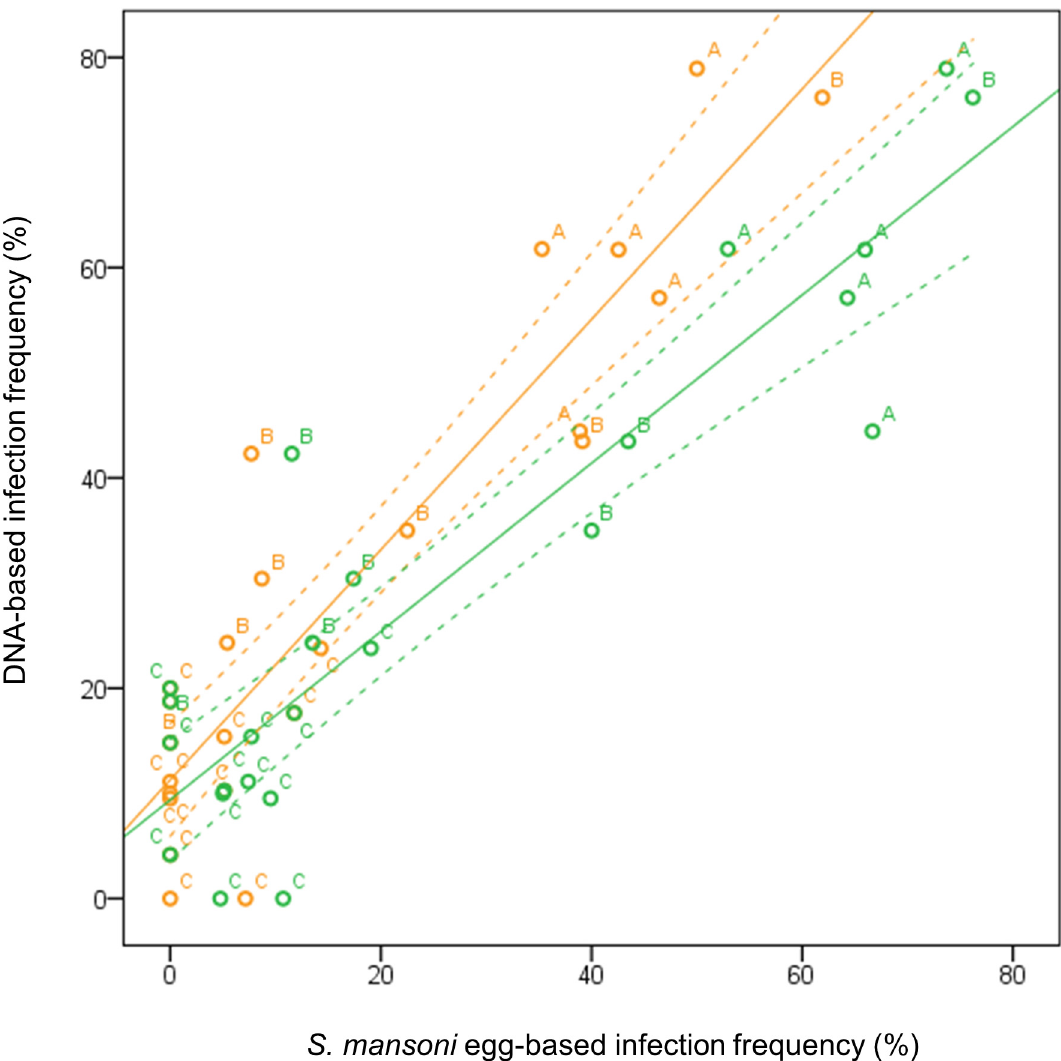
Fig 2. Relationship between egg- and DNA-based S . mansoni infection frequencies in Kenyan schools. Orange dots refer to infection frequencies based on microscopy performed on one stool sample, and green dots to infection frequencies based on three stool samples. Solid lines indicate regression lines and the dotted lines indicate their corresponding 95% confidence intervals. Schools with samples sizes < 15 were excluded. Pearson ’ s correlation coefficients were 0.850 and 0.826, respectively (both p < 0.001). ‘ A ’ indicates schools located within 1200m of the Victoria Lake, ‘ B ’ those between 1200 and 3800m, and ‘ C ’ indicates schools located farther than 3800m from the Lake (Foo et al., manuscript in